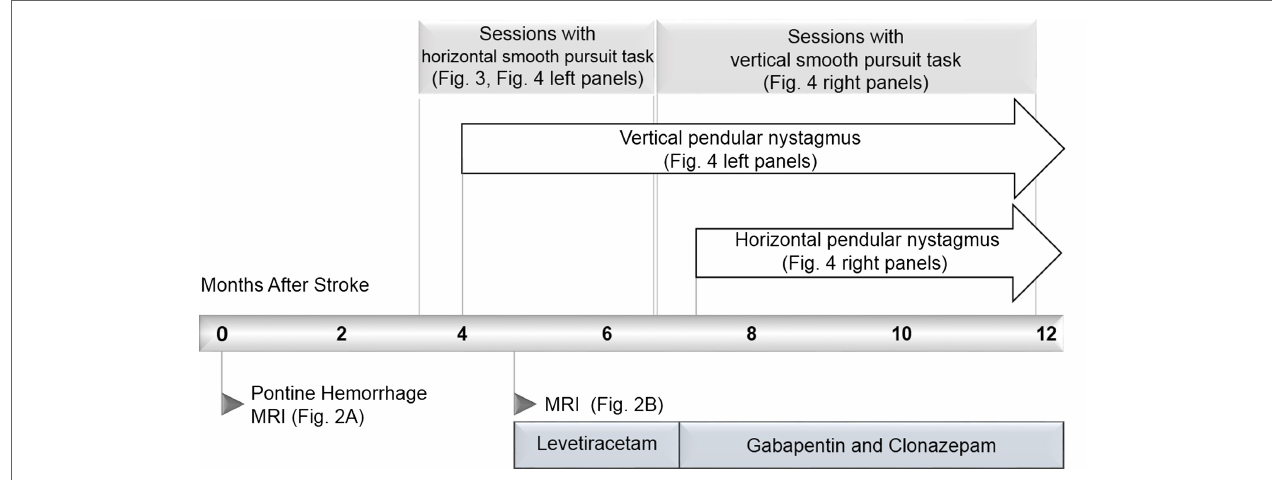
FIGURe 1 | timeline of important events in the case with references to other Figures